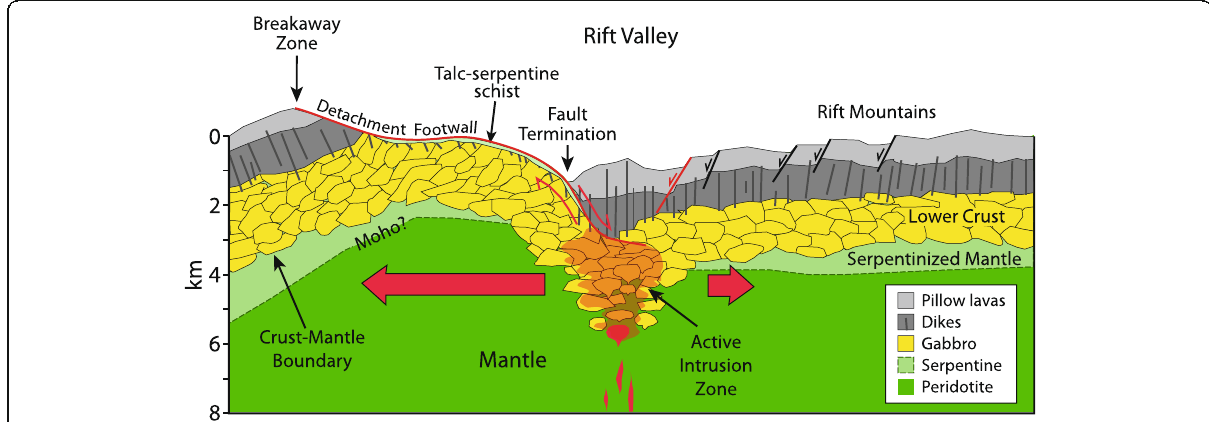
Fig. 1 Cartoon showing formation of an oceanic core complex on a non-conservative “ plutonic growth fault, ” also known as an oceanic detachment fault. Red arrows show spreading asymmetry similar to that documented at Atlantis Bank due to fault capture causing the majority of newly accreted crust to spread to the left in the figure. Talc-serpentine schist (~ 1 m thick) is exaggerated for graphical purposes and is shown intruding along the active detachment fault between the upper crust and the gabbro laterally from where it crosses into mantle peridotite near the transform or a ridge